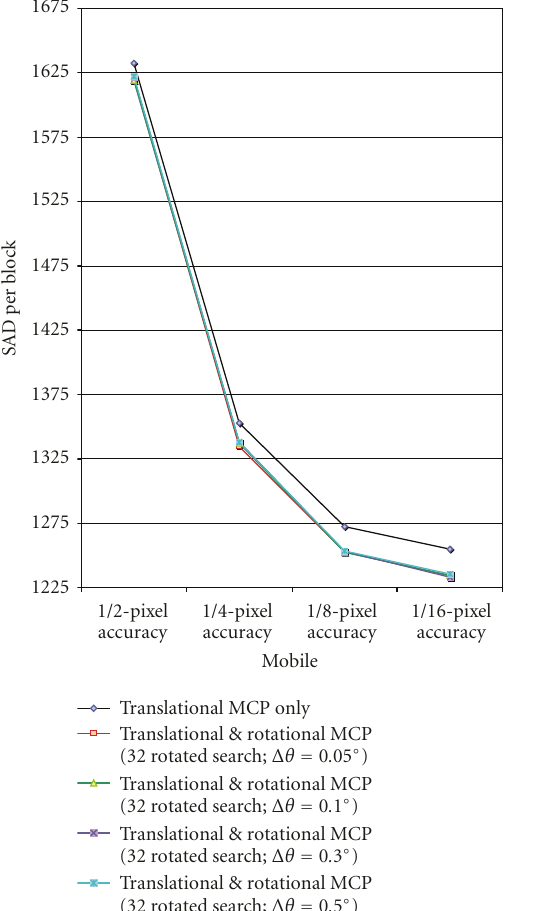
Figure 9: Average SAD per block in sequence Akiyo